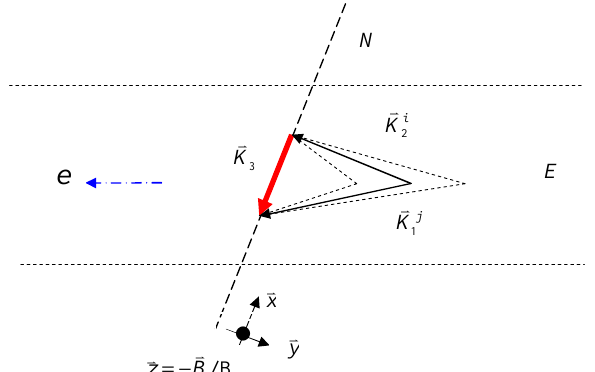
Fig. 8. A sketch of the STARE Norway radar observational geome- try over the EISCAT spot. The secondary wave with wave vector k 3 , red, is formed by the subtraction of two primary waves k 2 and k 1 , which are traveling nearly horizontally with a positive and negative flow and random aspect angle 0.3–0.5 ◦ inside the auroral westward electron flow (for more details see